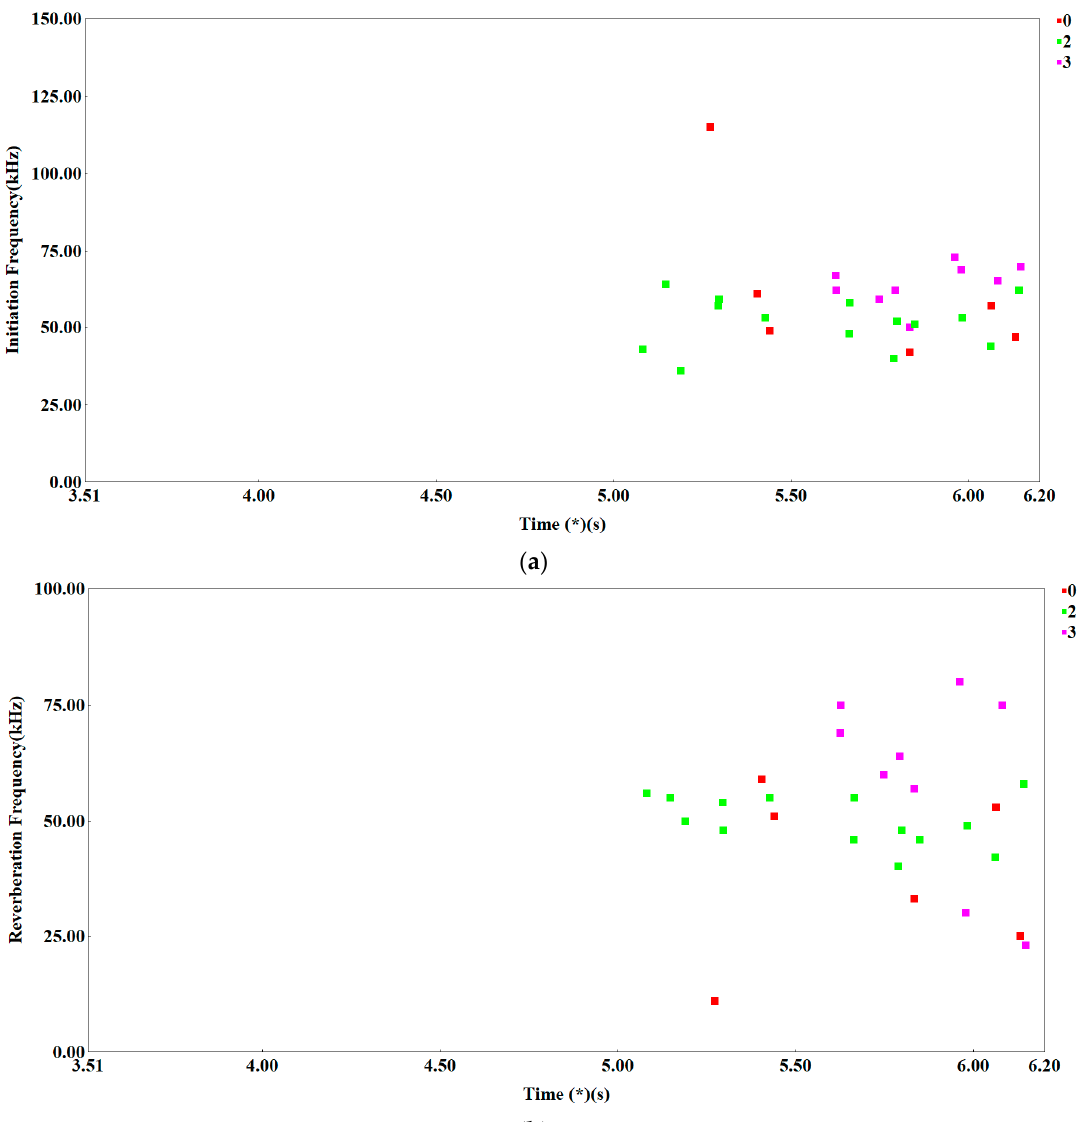
Figure 7. Scatterplot: ( a ) Initiation frequency (IF) (kHz) vs. time (s); and ( b ) reverberation frequency (RF) (kHz) vs. time (s).